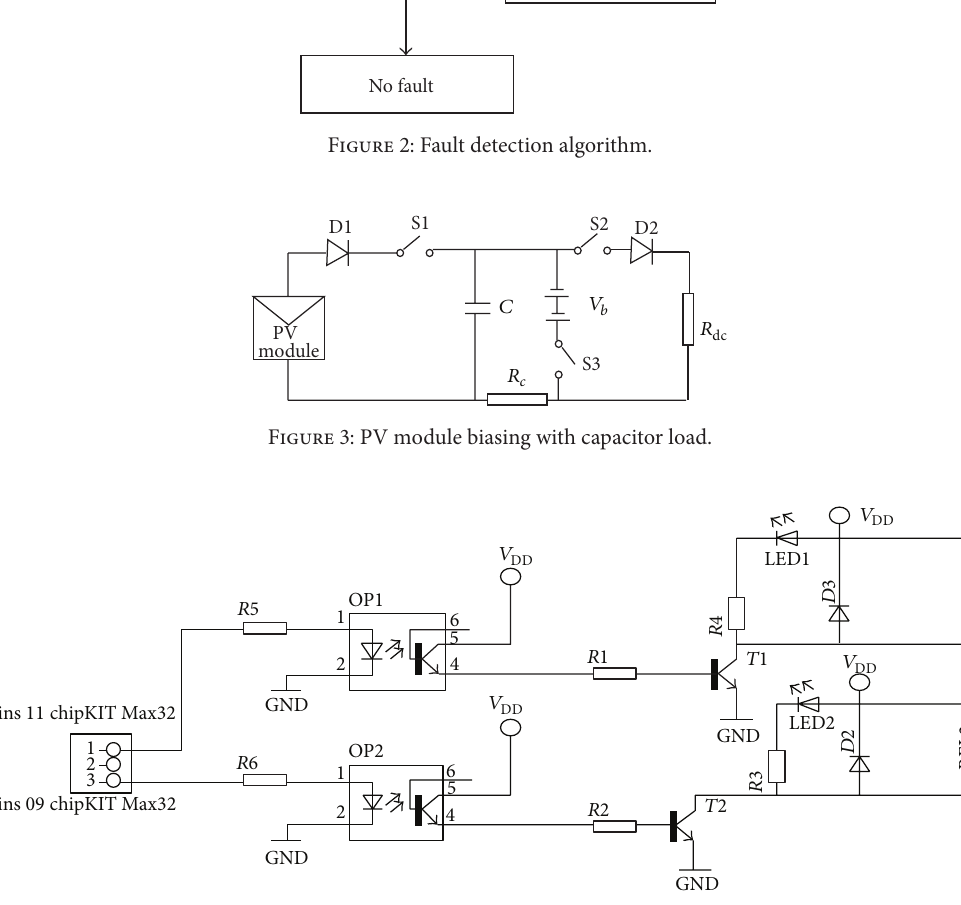
Figure 4: Electronic structure of power and control